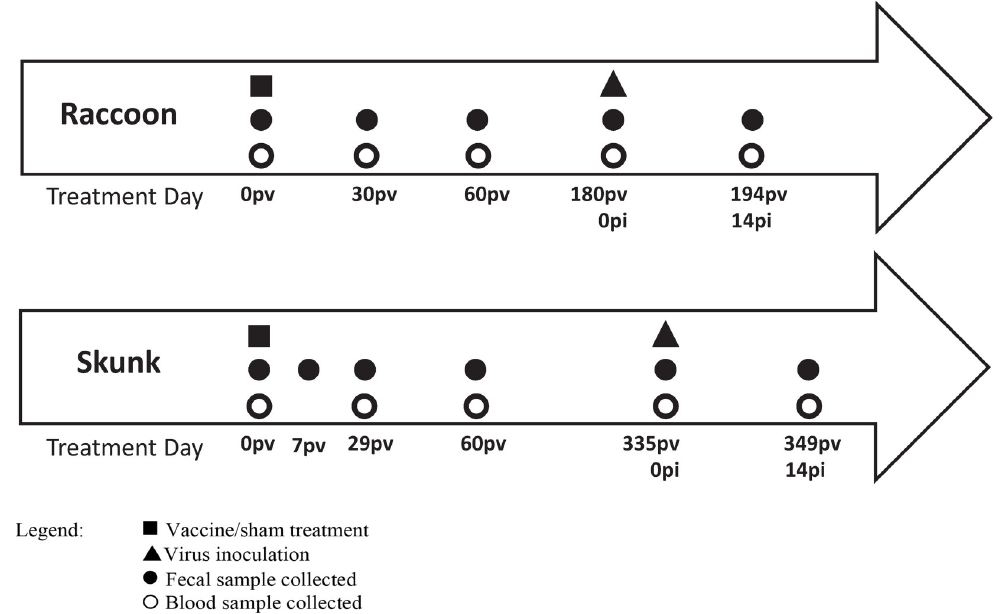
Fig 1. Sample collection schedule at post-vaccination (pv) and post-infection (pi) timepoints for subjects in challenge cohorts (receiving rabies vaccine or sham treatment followed by subsequent challenge with rabies